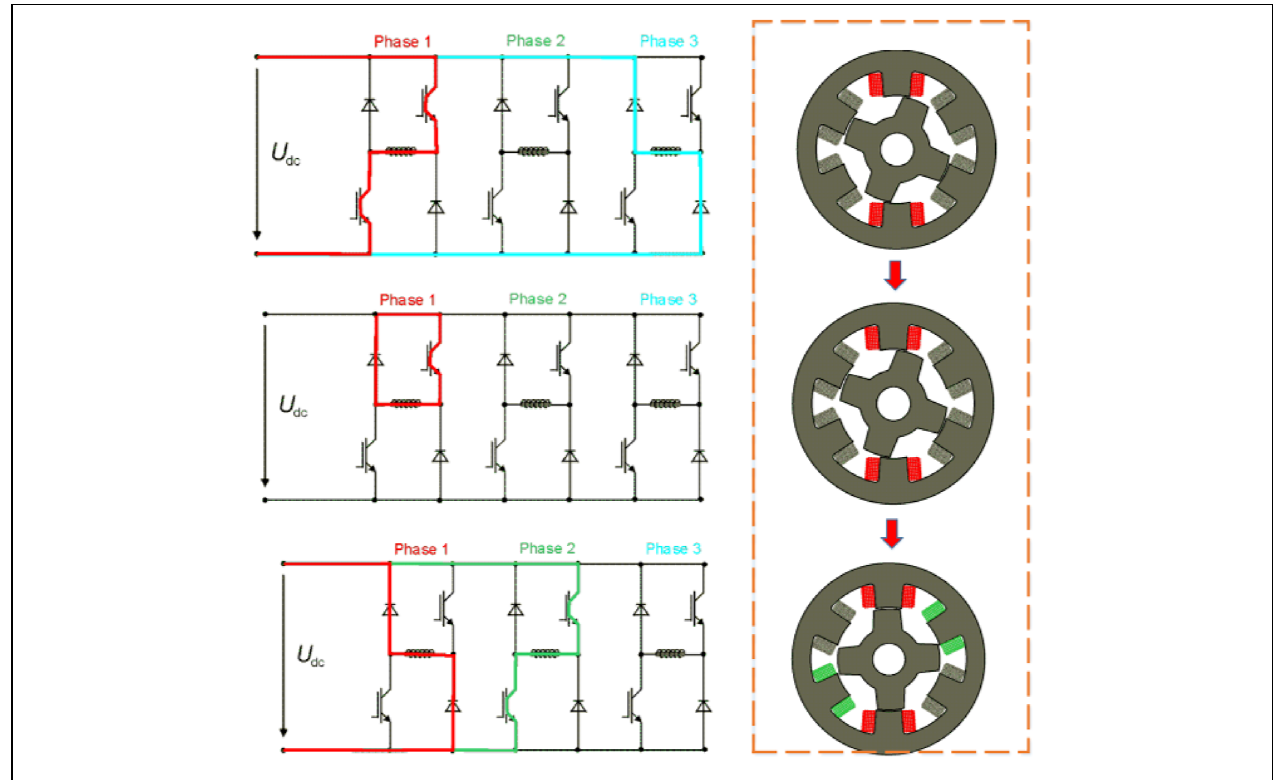
FIGURE 3 | Flow diagram of the working mode for three-phase 12/8 pole SRM.